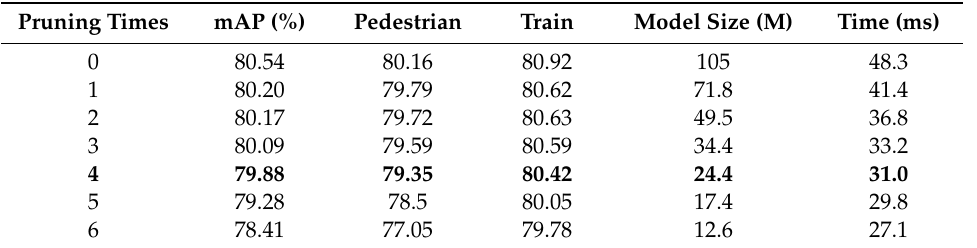
Table 10. Pruning results of the railway dataset.